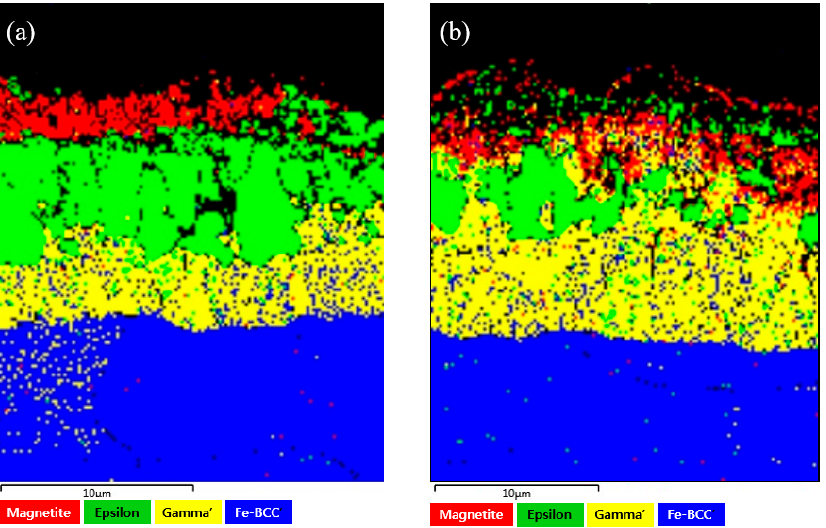
Figure 4. EBSD results for surface hardened layer: ( a ) air-specimen and ( b ) steam-specimen.